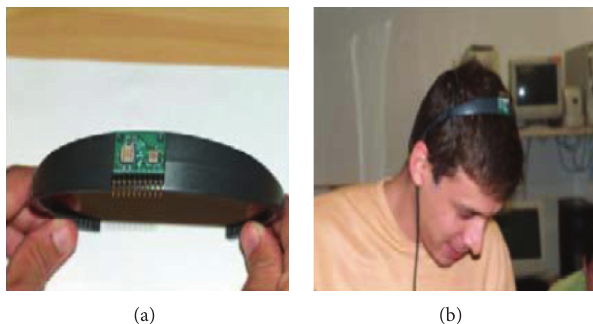
Figure 5: The SBIMouse . (a) The headband contains the SBIMouse electronics. (b) A user wearing the SBIMouse —a head-mounted device. Images from